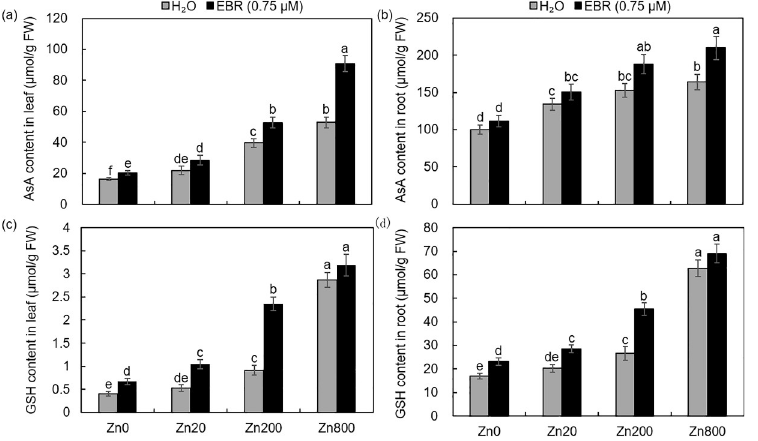
Fig 5. Total AsA and GSH levels in leaves and roots of S . lineare upon Zn and EBR treatments. (a, b) AsA levels; (c, d) GSH